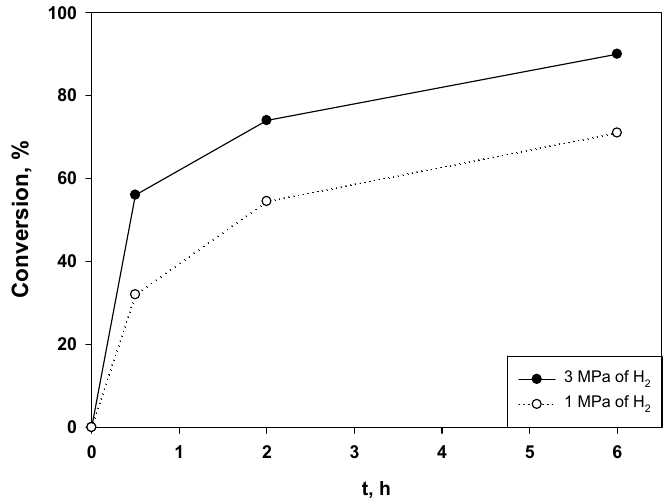
Figure 7. Hydrogenation of phenol in water in the presence of G2-dendr- meso -SiO 2 -Ru. Reaction conditions are: S/Ru = 1843, at 80 °C, m (substr.) = V (H 2 O). In comparison with the earlier described materials, based on dendritic networks, with high reaction rates achieved, first of all, due to the high metal loading in the catalyst [57], the newly synthesized mesoporous hybrid catalyst appeared to be much more effective (Table 3). Thus, the turnover frequency for G2-dendr- meso -SiO 2 -Ru at 80 °C and 3 MPa of hydrogen takes more than 6000